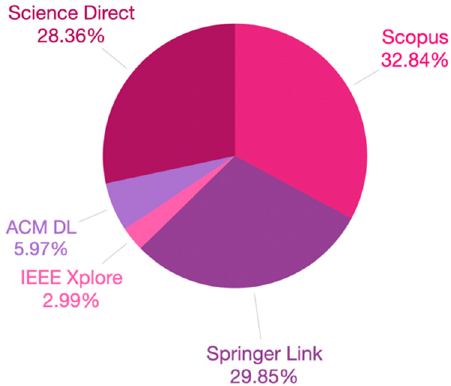
Figure 2. Articles contributed by the electronic databases.